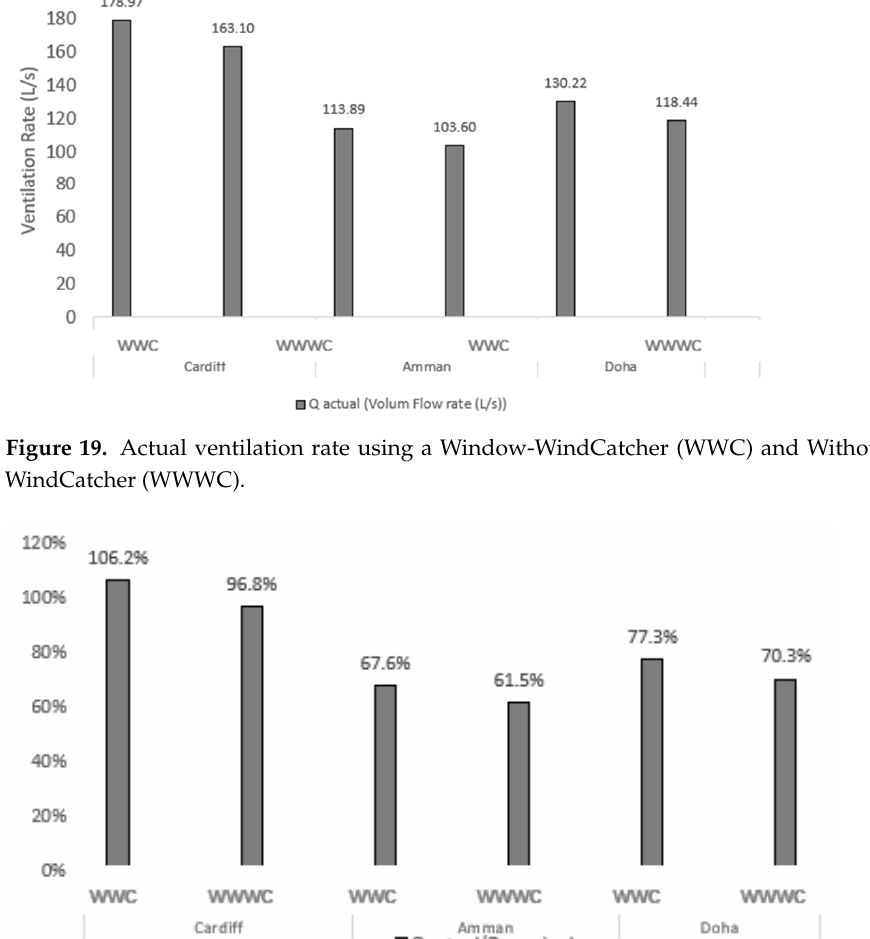
Figure 19. Actual ventilation rate using a Window-WindCatcher (WWC) and Without Window- WindCatcher (WWWC).